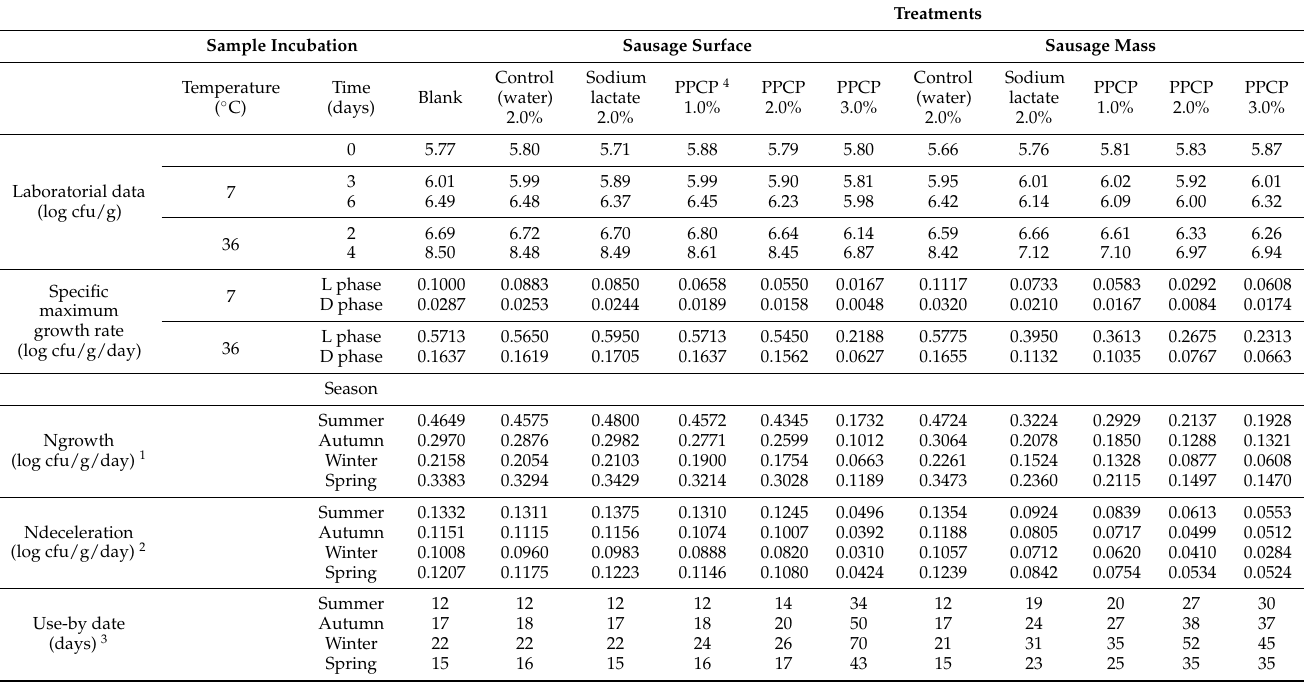
Table 4. Durability study of vacuum-packaged cooked sausage